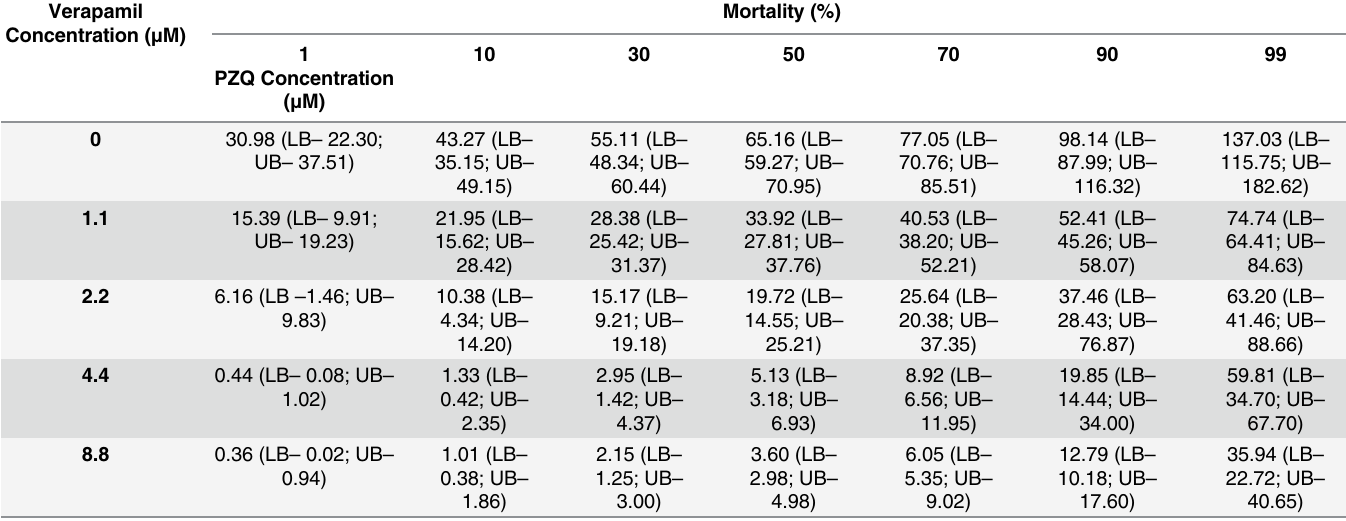
Table 3. Lethal doses of PZQ (LB — Lower Bound; UB — Upper Bound) calculated using Probit regression model with a 95% confidence, for S . man- soni PZQ-resistant parasite strain males in the presence of various concentrations of Verapamil. Verapamil Concentration ( μ